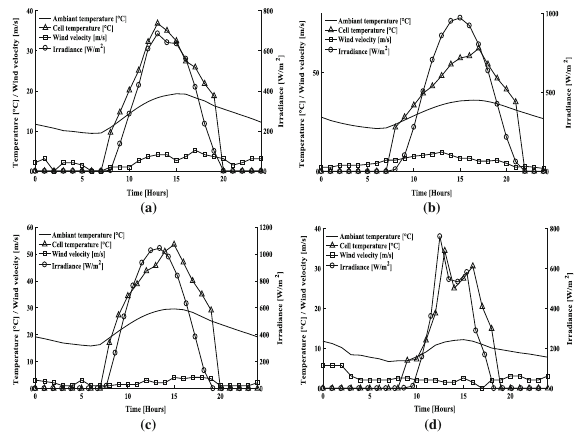
Fig. 6 Different daily atmospheric conditions for a March 21,